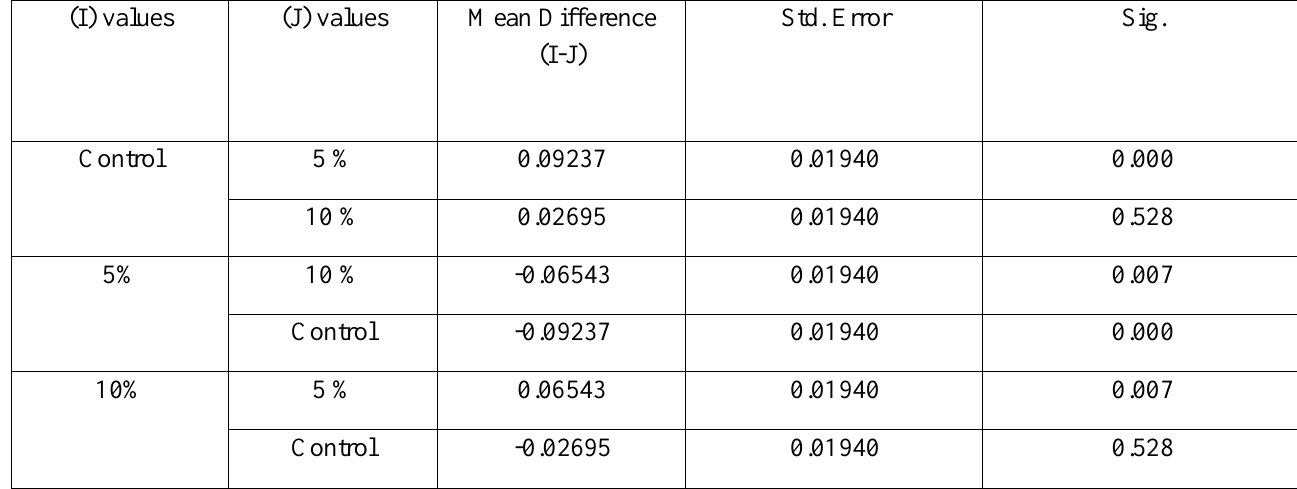
Table 5: Post HOC test between groups of thermal conductivity